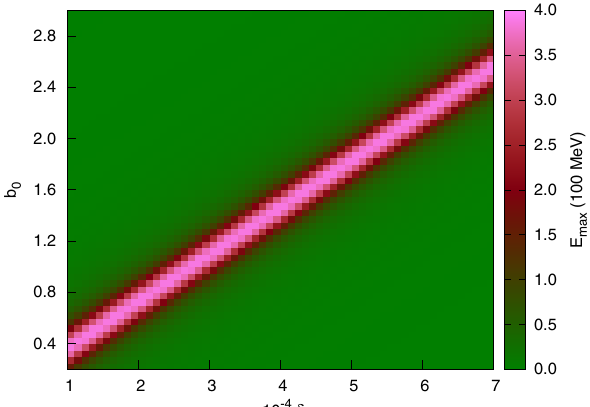
FIG. 8. Maximum energy as a function of magnetic field ( b 0 ) and detuning parameter ( (cid:5) ) for the phase modulation parameter (cid:3) ¼ 0 : 5 .